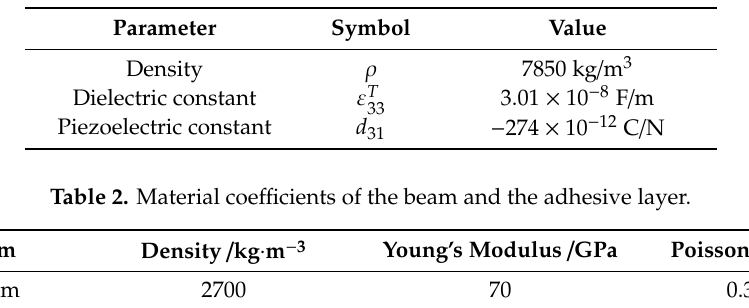
Table 1. Properties of piezoelectric patch.